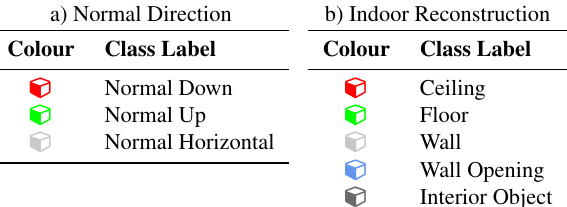
Table 1. Colour schemes for voxel